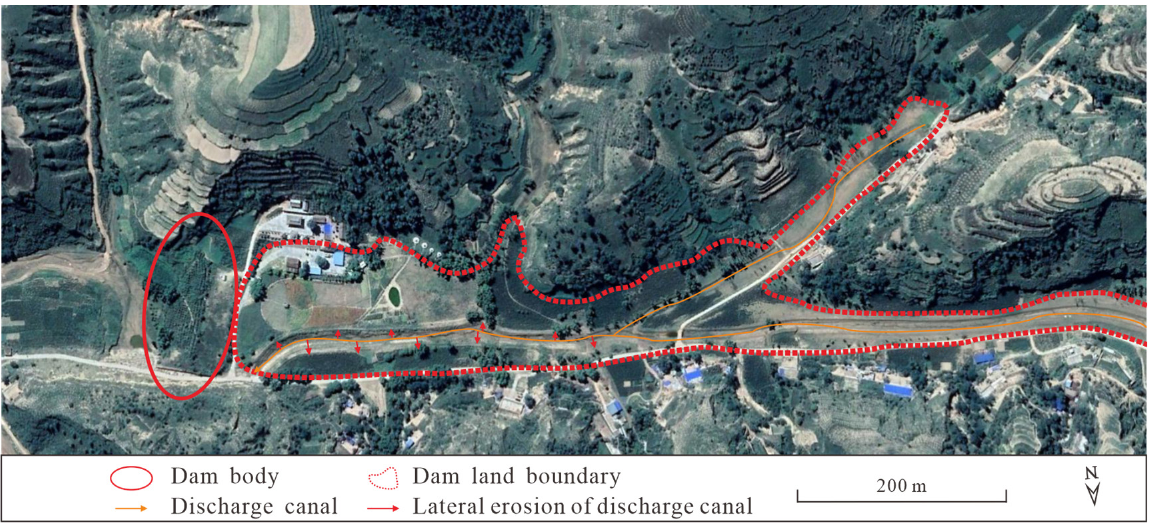
Figure 7. Discharge canals can encroach and shrink dam land area.